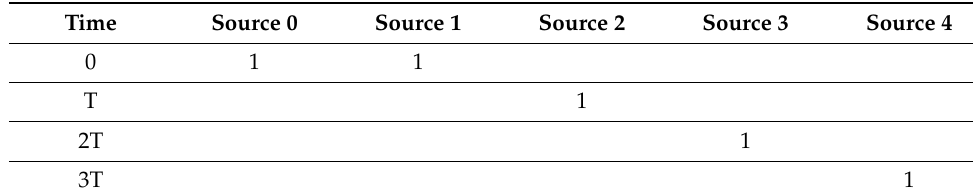
Figure 8. Topology 1. Table 6. Packet generation scenario in topology